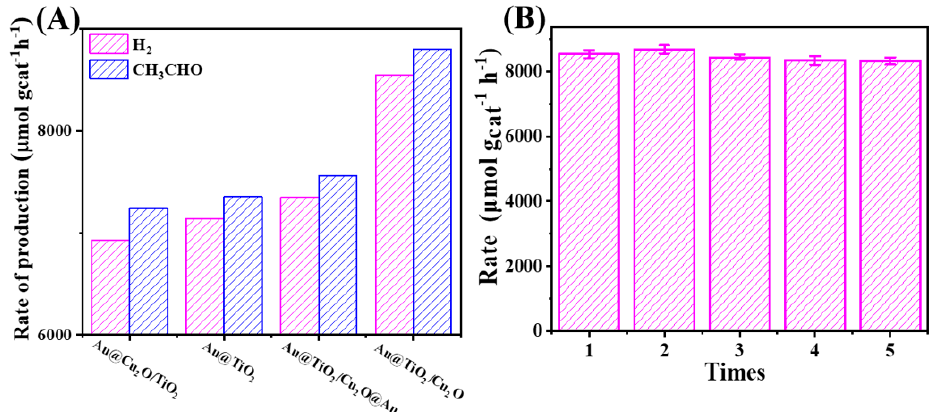
Figure 6. ( A ) H 2 and acetaldehyde production rate via the photoreforming of ethanol under simulated solar light (AM 1.5G). ( B ) The cycle tests of Au@TiO 2 /Cu 2 O for photocatalytic hydrogen evolution. Conditions: suspension of the photocatalyst (1 g / L) in ethanol under stirring were irradiated with simulated solar light at Ar atmosphere (1.4 bar) for 6